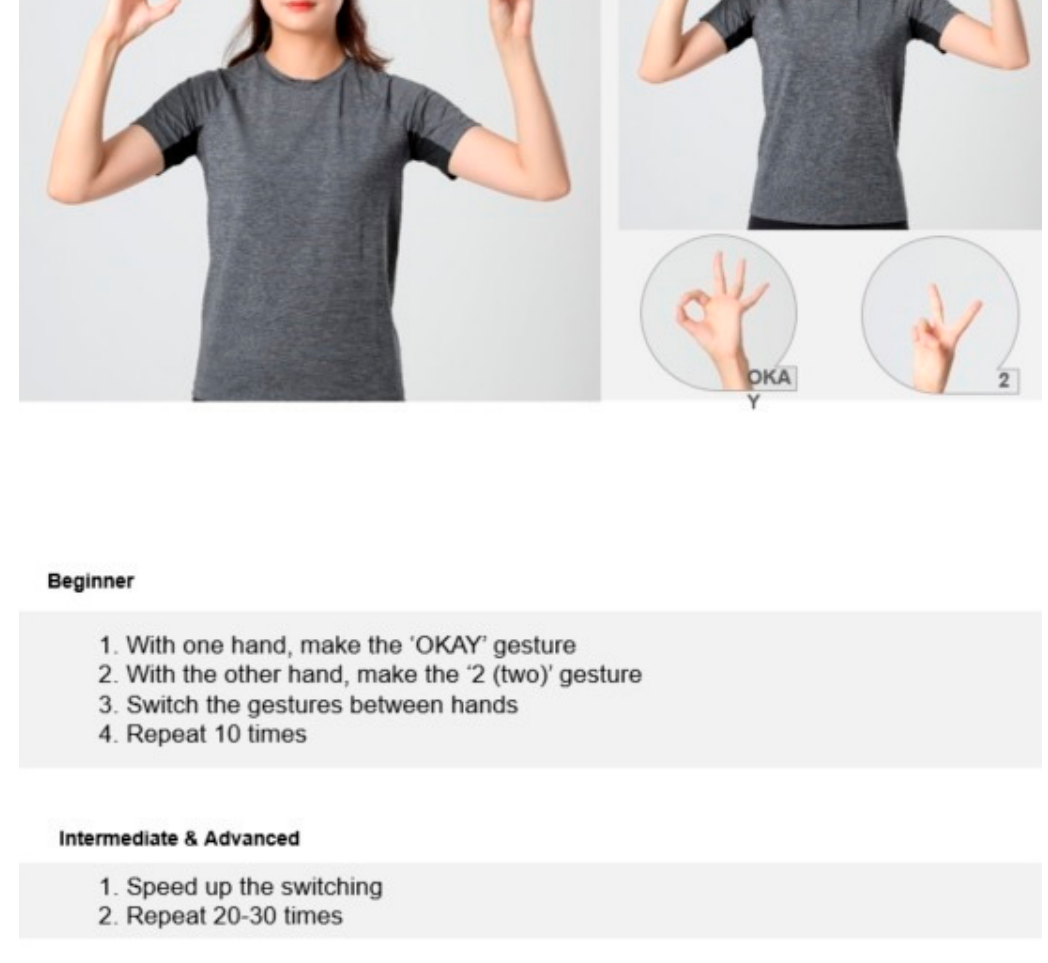
Figure A25. Detailed description and components of each movement in the “Okay 2” finger-and-toe exercise.